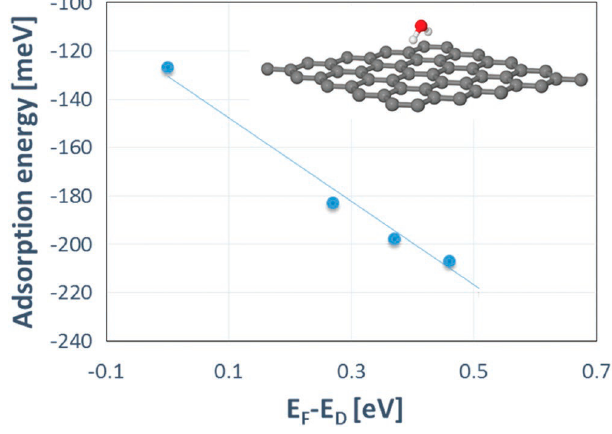
Figure 5. DFT-predicted adsorption energy of a H 2 O molecule on monolayer graphene versus (E F − E D ) values [44]. Note: The case when (E F − E D ) corresponds to neutral graphene, for which Fermi level coincides with the Dirac point. While (E F − E D ) value of 0.45 eV is related to n -type doping of ≈ 1.5 × 10 13 cm − 2 . Copyright 2019 WILEY-VCH Verlag GmbH & Co. KGaA, Weinheim,